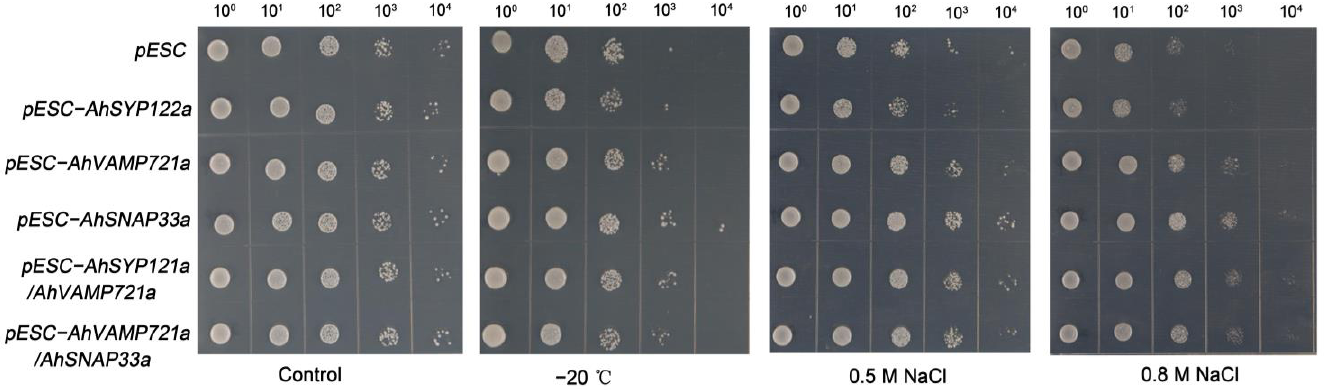
Figure 8. Growth of transformed yeast harboring pESC- AhSYP122a , pESC- AhVAMP721a , pESC- AhSNAP33a , pESC- AhSYP122a/AhSNAP33a or pESC- AhVAMP721a/AhSNAP33a vectors under –20 ℃ for 1 h, and 0.5 M or 0.8 M NaCl for 5 h. The experiment was repeated three times.